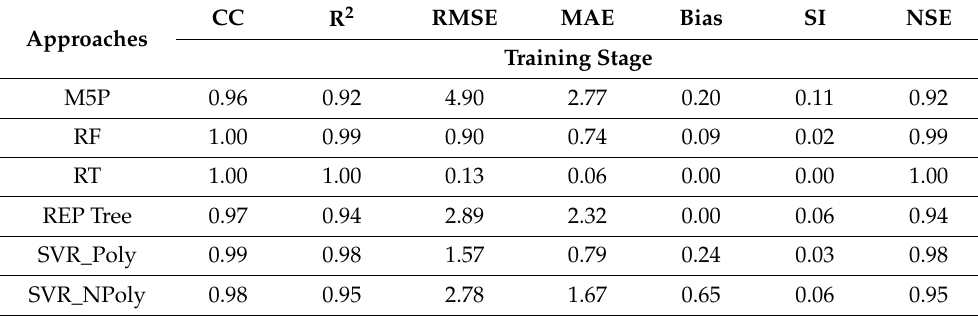
Table 6. Performance evaluation parameters M5P, RF, RT, REP Tree, SVR_Poly (Polynomial